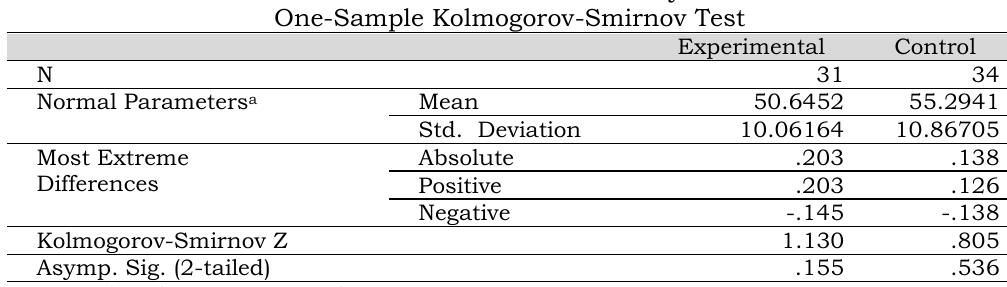
Table 3. Standard normality